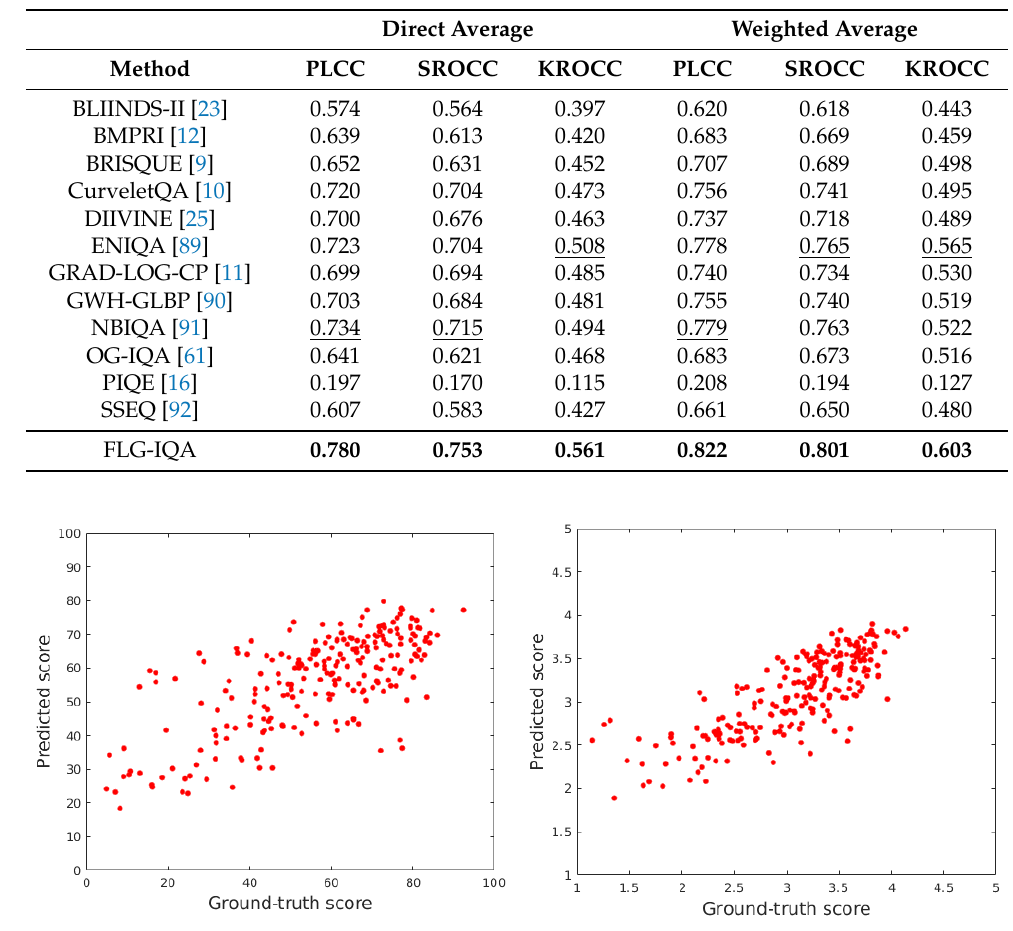
Table 9. Comparison to the state-of-the-art. Direct and weighted average PLCC, SROCC, and KROCC are reported based on the results measured in CLIVE [45], KonIQ-10k [46], and SPAQ [47]. The best results are in bold and the second-best results are underlined.